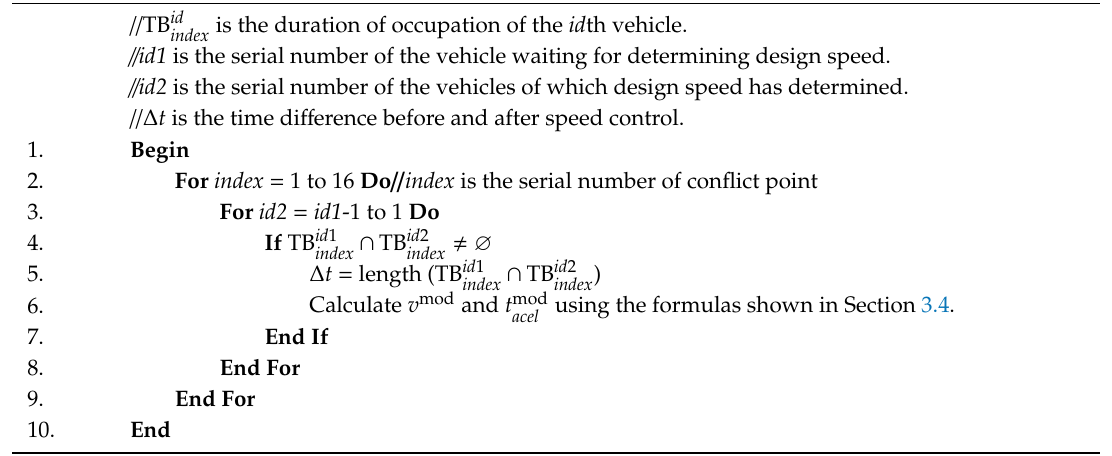
Algorithm 2 Geometric Translation-based Intersection Coordination Algorithm (TICA)